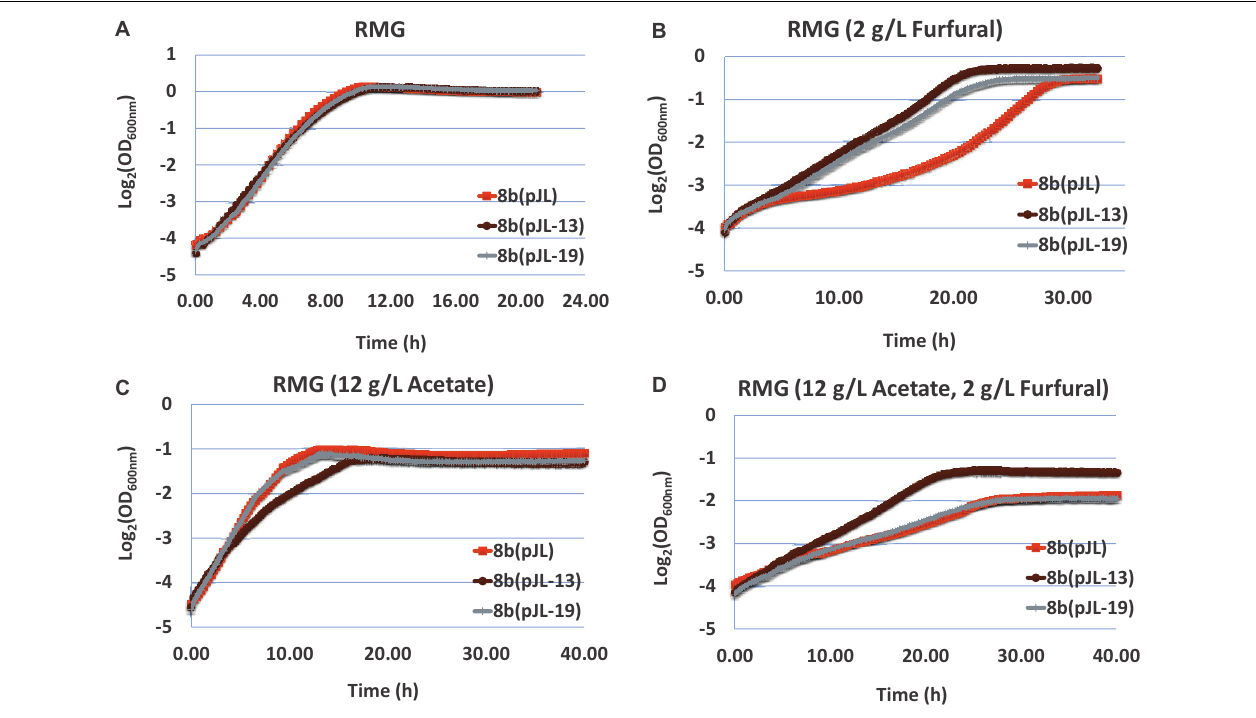
FIGURE 5 | The growth of 8b (pJL) containing empty vector pJL130Sp as control and 8b derivative strains of 8b (pJL-13) and 8b (pJL-10) containing plasmid pJL-13 or pJL-19 to express operon ZMO0003-6 or ZMO0465 with its native promoter, respectively. The growth was monitored using Bioscreen C in RMG5 medium at 33 ◦ C (A) . Other conditions included RMG5 with the supplementation of 2 g/L furfural (B) , 12 g/L acetate (C) , as well as both 2 g/L furfural and 12 g/L acetate (D) . More than two independent experiments were performed with similar results, and triplicate was used in each experiment. Spectinomycin at a final concentration of 100 µ g/mL was added into the